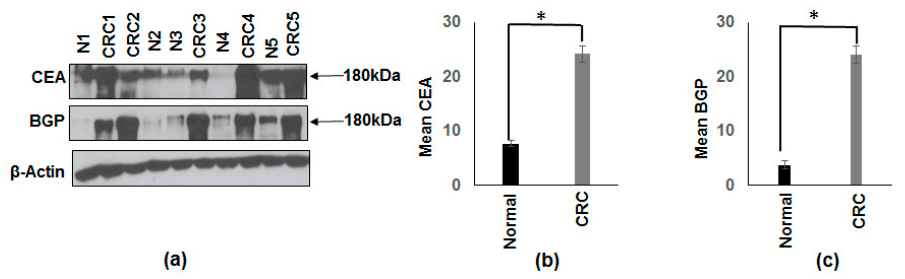
Figure 3. Increased protein expression of carcinoembryonic antigen (CEA) and biliary glycoprotein (BGP) from cancerous and corresponding normal tissues from patients with CRC were compared to normal colon from patients without colon cancer. ( a ) Whole tissue extracts from colon cancer (CRC) subjects and normal (N) subjects (included in this figure are four samples shown in Figure 1a with an additional sample making a total of five) were subjected to Western blot analysis using specific antibodies to CEA and BGP. Equal loading was confirmed with β -actin. A representative blot is shown for five normal subjects and five CRC subjects. ( b ) Densitometric values are expressed as fold increase of the ratio of CEA / β -actin (mean ± SEM) from 10 CRC and 10 normal patients, * p -value < 0.007. ( c ) Densitometric values are expressed as a fold increase of the ratio of BGP / β -actin (mean ± SEM) from 10 CRC and 10 normal patients, * p -value < 0.005. As shown in ( a ) the CRC patients exhibited increased protein expression of BGP and CEA compared to normal